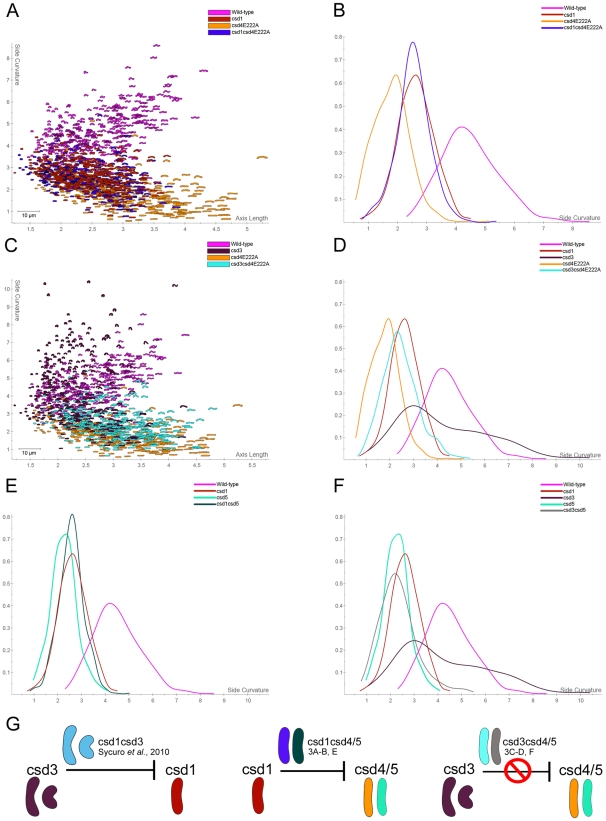
Morphological characterization of single and cross-shape class double mutants.A, C) Scatter plots arraying wild-type and mutant populations by cell length (x-axis, µm) and cell curvature (y-axis, arbitrary units). B, D–F) Smooth histograms displaying population cell curvature (x-axis) as a density function (y-axis). Bootstrapped Kolmogorov–Smirnov statistics of population cell curvature distributions: B) csd1csd4 vs. csd1 p = 0.31, csd1csd4 vs. csd4 p<0.00001; D) csd3csd4 vs. csd4 p<0.00001, csd3csd4 vs. csd3 p<0.00001, csd3csd4 vs. csd1 = 0.0055; E) csd1csd5 vs. csd1 p = 0.25, csd1csd5 vs. csd5 p<0.00001; F) csd3csd5 vs. csd5 p = 0.37, csd3csd5 vs. csd3 p<0.00001, csd3csd5 vs. csd1 p<0.00001. All mutant comparisons to wild-type had p<0.00001 (B, D–F). G) Summary of morphological epistasis relationships. The average cell contour model generated by CellTool is shown for each strain. Two contours are shown for the morphologically variable csd3 mutant representing two distinct aspects of the shape distribution of this mutant (curvature values of 3 (mode) and 6 (right-hand tail)). Strains used: LSH100, LSH123, LSH134, LSH146, MLH3, MLH4, NSH152a, NSH153a, NSH160a, NSH161.